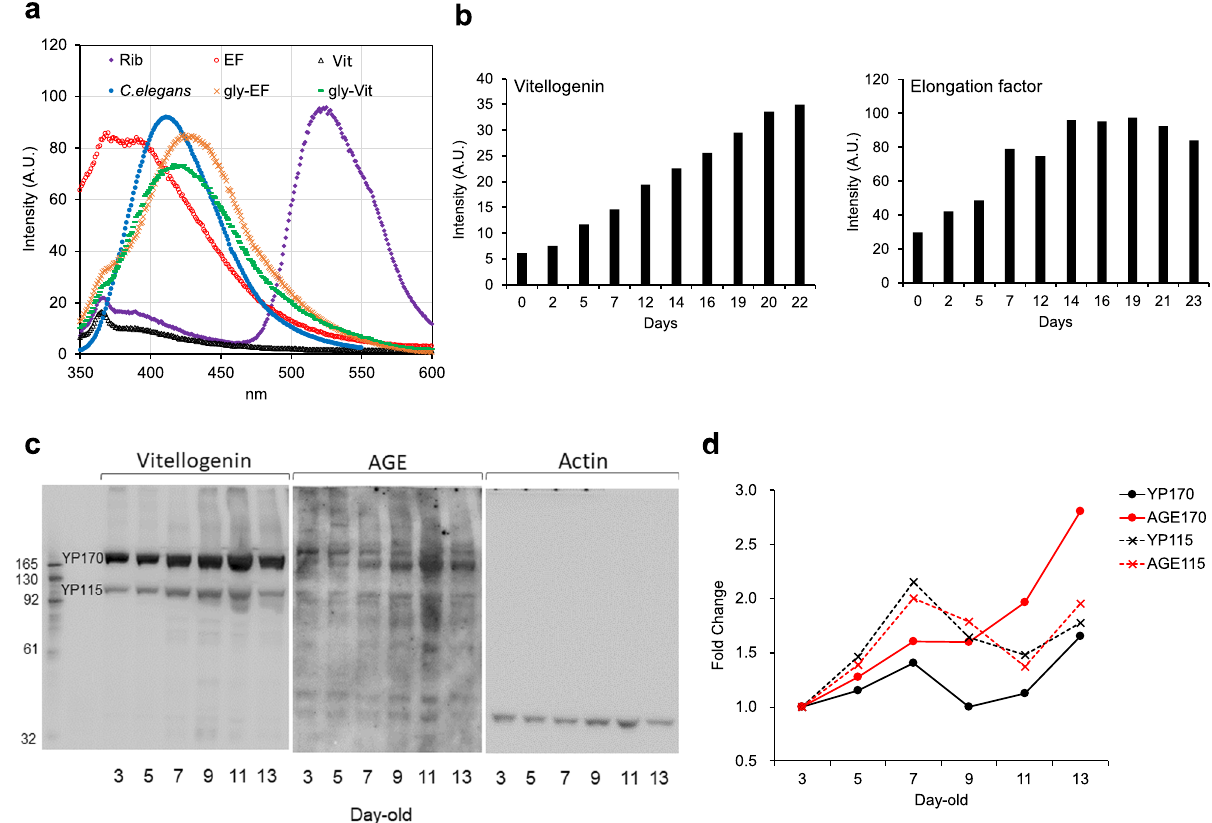
Fig. 6 Auto fl uorescence of vitellogenin (Vit) and elongation factor (EF). a Spectrophotometry (ex 325/em 350 – 600) of vitellogenin and elongation factor before and after glycation in vitro by ribose for 14 days: gly-Vit and gly-EF are glycated vitellogenin and glycate elongation factor, respectively. Ribo fl avin (Rib) is shown as a representative fl uorescent compound. Extract from 17-day-old worms (wild-type N2) is shown for comparison ( C. elegans ). b In vitro glycation of vitellogenin and elongation factor by ribose yielded increases in auto fl uorescence